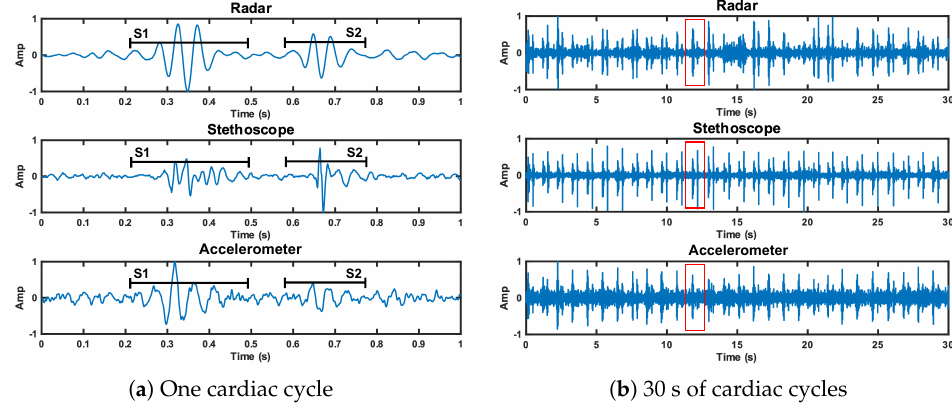
Figure 12. Time domain representation of the radar, stethoscope, and accelerometer measurement techniques. Plot ( a ) depicts a close up of one cardiac cycle, circled in red in plot ( b